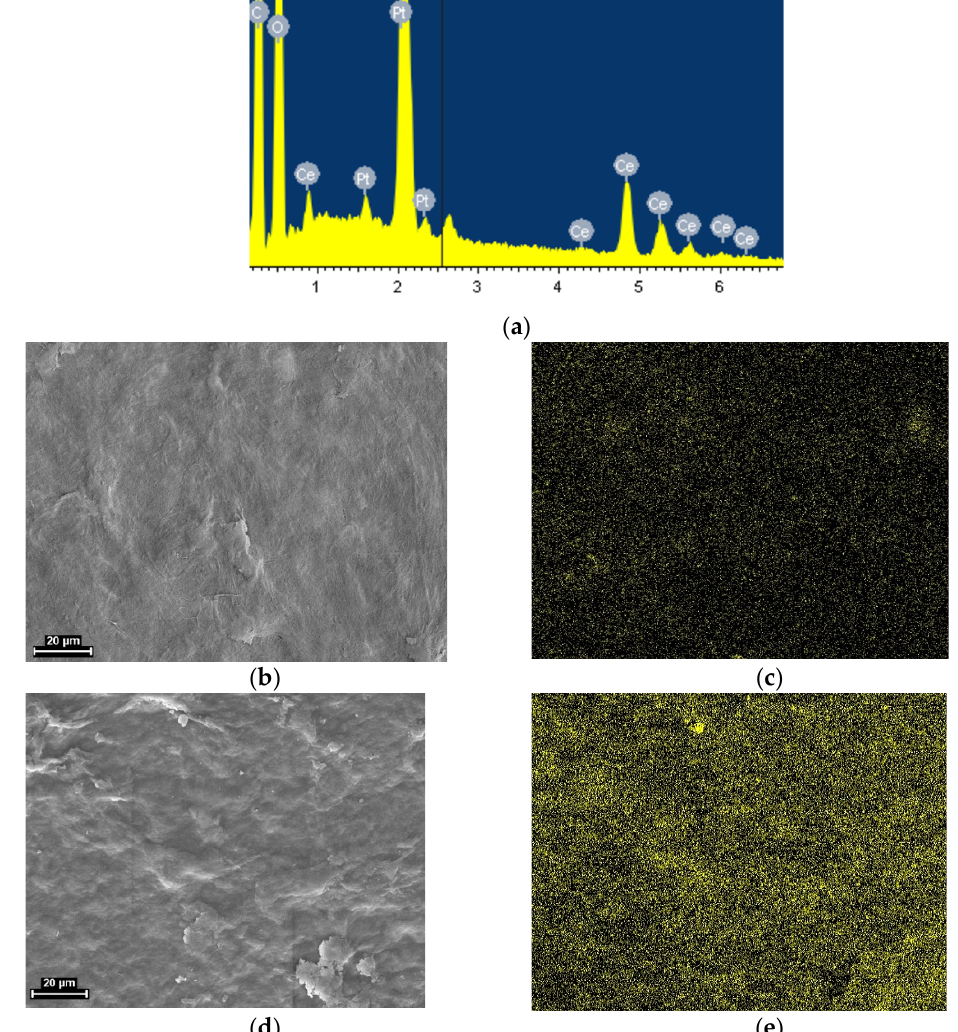
Figure 3. ( a ) An example of the EDX spectrum of the composite BC-CeO 2 sample; SEM images (left side) and EDX maps of cerium distribution (right side) on the surface of the BC-ceria nanocomposite samples with: ( b , c ) 1 wt.% CeO 2 ; ( d , e ) 5 wt.% CeO 2 .